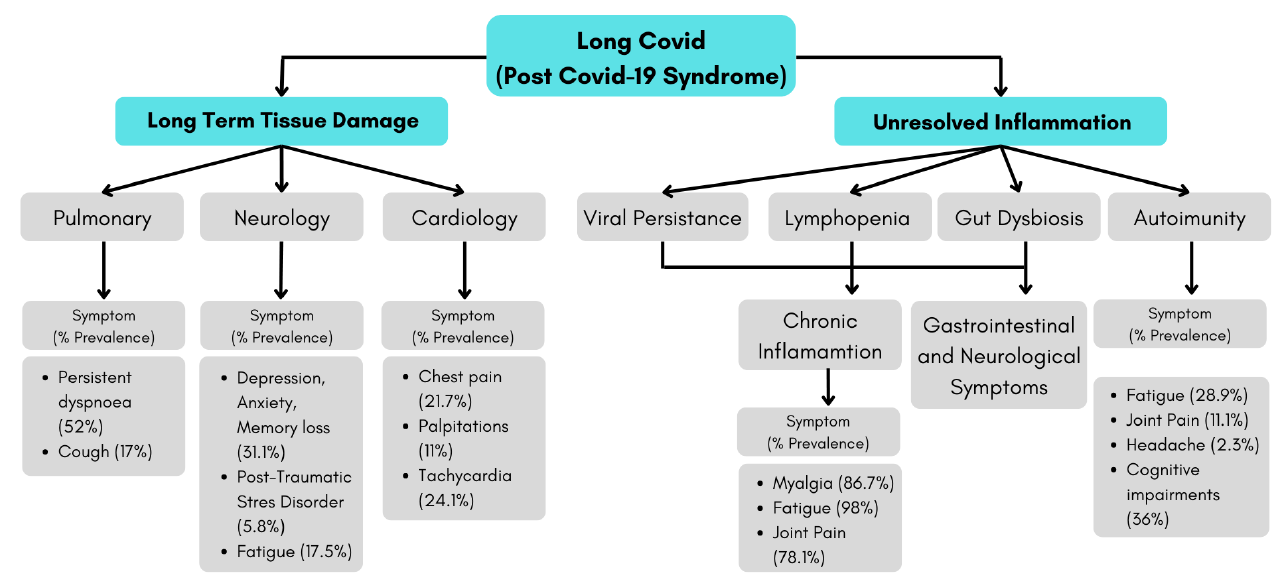
Figure 3. Putative pathophysiology and symptoms of long